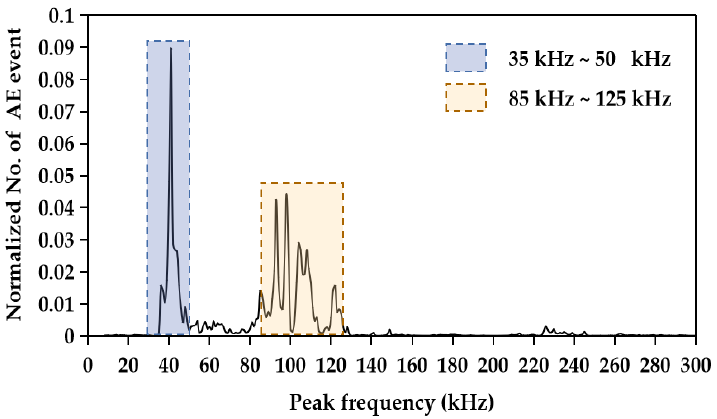
Figure 10. Peak frequency distribution of crumb rubber concrete.